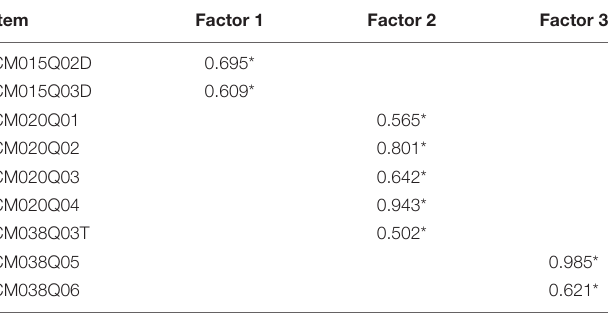
TABLE 3 | Rotated factor loading matrix for the 3-factor model for response times